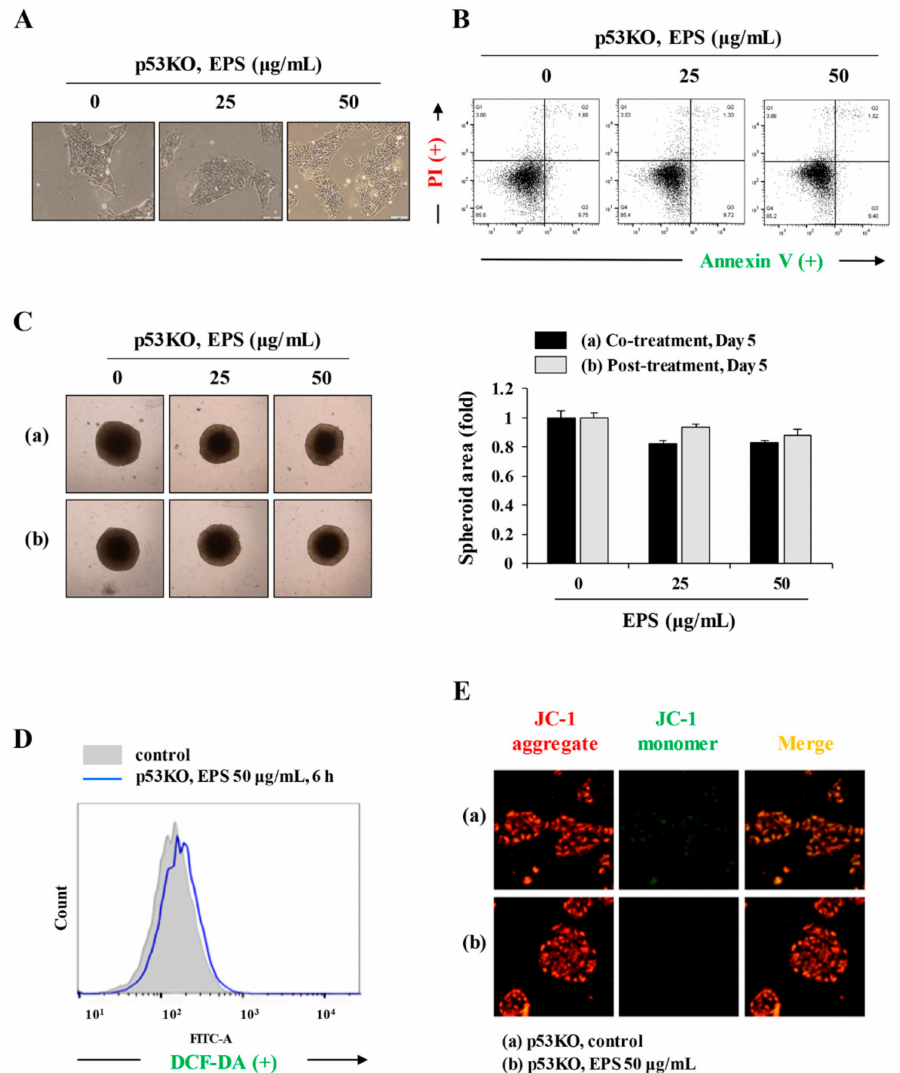
Figure 6. EPS shows no cytotoxicity in p53KO hiPSCs. ( A ) p53KO hiPSCs were treated with 25 and 50 µ g / mL EPS for 24 h and the cell morphology was observed under an inverted microscope. ( B ) After treatment with EPS, apoptosis in p53KO hiPSCs was assessed with annexin V / PI double staining. ( C ) p53KO hiPSCs assembled to spheroids were incubated in the presence or absence of 25 and 50 µ g / mL EPS from day 0 (a) or day 2 (b). After 5 days, spheroids were photographed and relative spheroid areas were determined using Image J software. Data are expressed as the mean ± SD from triplicate samples. ( D ) p53KO hiPSCs treated with 50 µ g / mL EPS for 6 h were incubated with DCF-DA (5 µ M) for 30 min, and then analyzed intracellular reactive oxygen species (ROS) levels using flow cytometry. ( E ) p53KO hiPSCs were treated with 50 µ g / mL EPS for 6 h, stained with JC-1 dye, and observed under a fluorescence